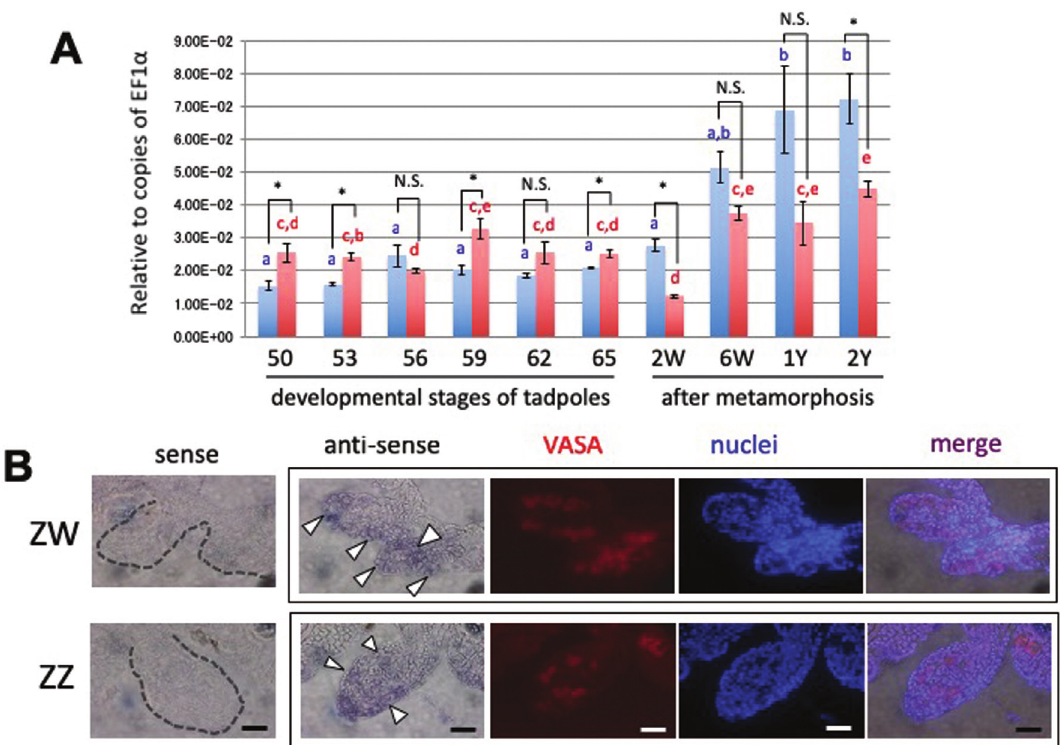
Figure 4 - Expression of PACT/PRKRA mRNA in developing ZW and ZZ gonads. (A) Quantitative RT-PCR analysis of Pact/Prkra mRNA during go- nadaldevelopmentofZW(red)andZZ(blue)tadpolesandadultsin X.laevis .cDNAsweresynthesizedusingtotalRNAsfromZWandZZgonadsatvar- iousstagesoftadpolesaftersexdetermination,andat6weeks,1year,and2yearsoffrogsaftermetamorphosis,andthenamplifiedbyPCRusingspecific primer pairs as described in Table S1. W and Y show weeks and year(s), respectively. EF1 (cid:4) was used for normalization. RT-qPCR data represent the mean (n=3) and SD. Values are expressed as mean (cid:3) SE, n = 3. Differences among stages were evaluated by one-way ANOVA followed by the Tukey HSD test ( p < 0.05). Mean values not sharing the same letters are significantly different from each other. Sexual differences between ZZ and ZW gonads at each stage were evaluated or by Student’s t -test (* p < 0.05). N.S., not significant. (B) Distribution of Pact/Prkra mRNAs on transverse sections of ZW and ZZ tadpole gonads at stage 56. Whole-mount in situ hybridization of the gonads with the attached mesonephros was performed with the Pact/Prkra sense or anti-sense RNA probe, followed by 7- (cid:2) m cryostat sectioning. The sections were treated with an anti-VASA monoclonal antibody to identify germ cells (red) and Hoechst 33258 for nuclei (blue). Note that the nuclei in germ cells were faintly stained by Hoechst 33258. Arrowheads indicate Pact/Prkra -expressing germ cells. Scale bars, 20 (cid:2)